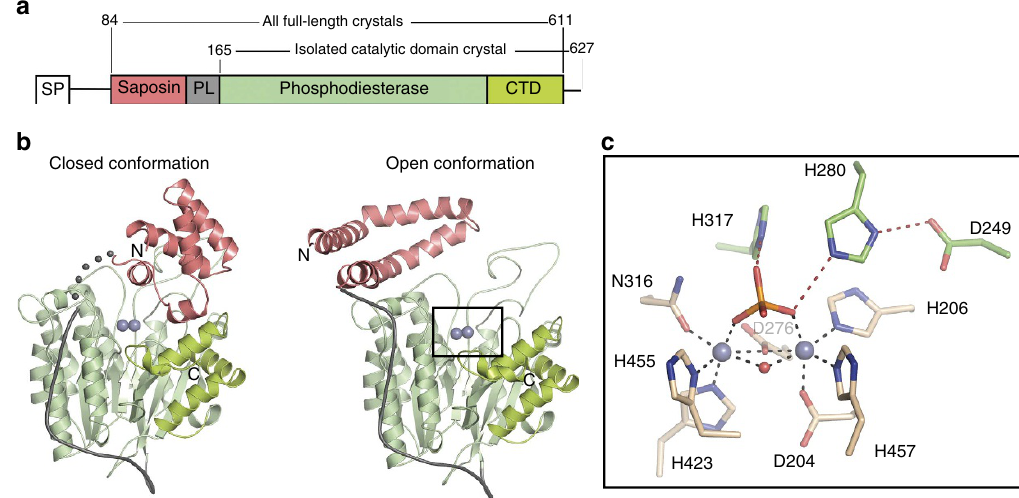
Figure 1 | Structural overview of ASMase. ( a ) Domain organization of ASMase. SP, signal peptide; PL, proline-rich linker. ( b ) Closed and open ASMase coloured as in a . Consecutive grey spheres indicate the disordered linker between closed ASMase sap and ASMase cat in one molecule of the asymmetric unit. Boxed region magnified in c is not in the identical orientation. Glycans are omitted for clarity. Zincs are indicated as purple spheres. ( c ) ASMase active site. Zinc interactions are shown as dashes. Zinc–zinc distance ¼ 3.6Å. Zinc–ligand distances range from 2.0 to 2.1Å. Phosphate is coloured orange and red. Shown are zinc-interacting residues (beige) and residues important for leaving group protonation and substrate binding